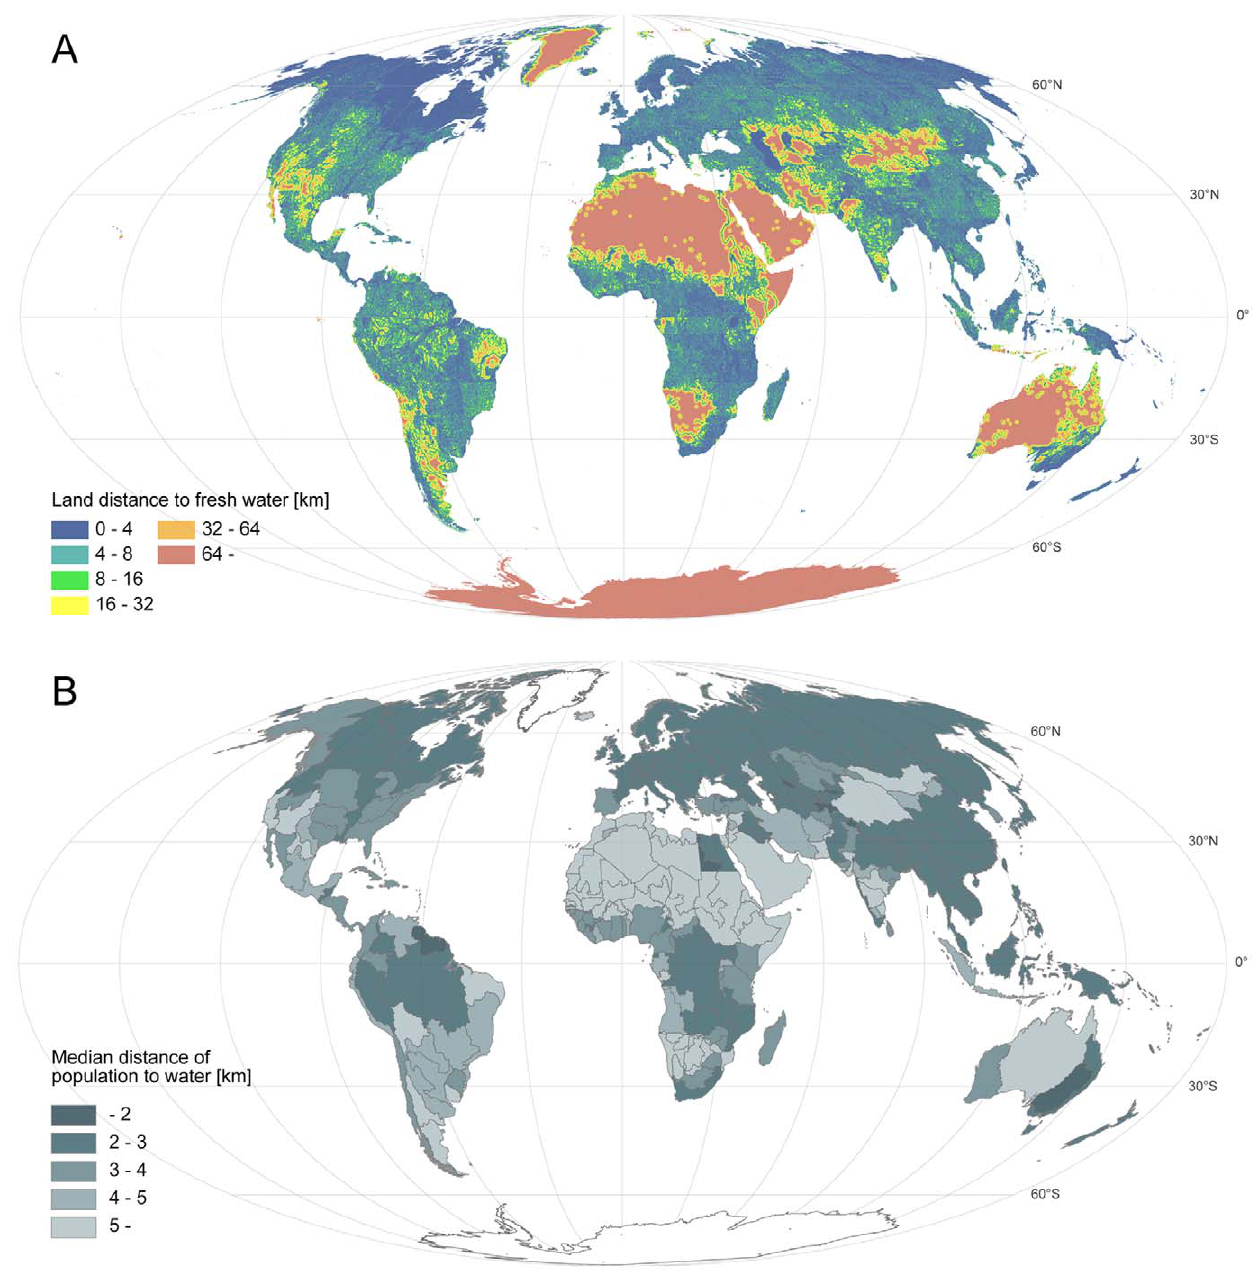
Figure 1. Distance to water. A: Average land distance to fresh water for each square kilometre of land ( dw land ). B: Median distance of population to water ( dw pop ) at FPU (Food Production Unit) scale.